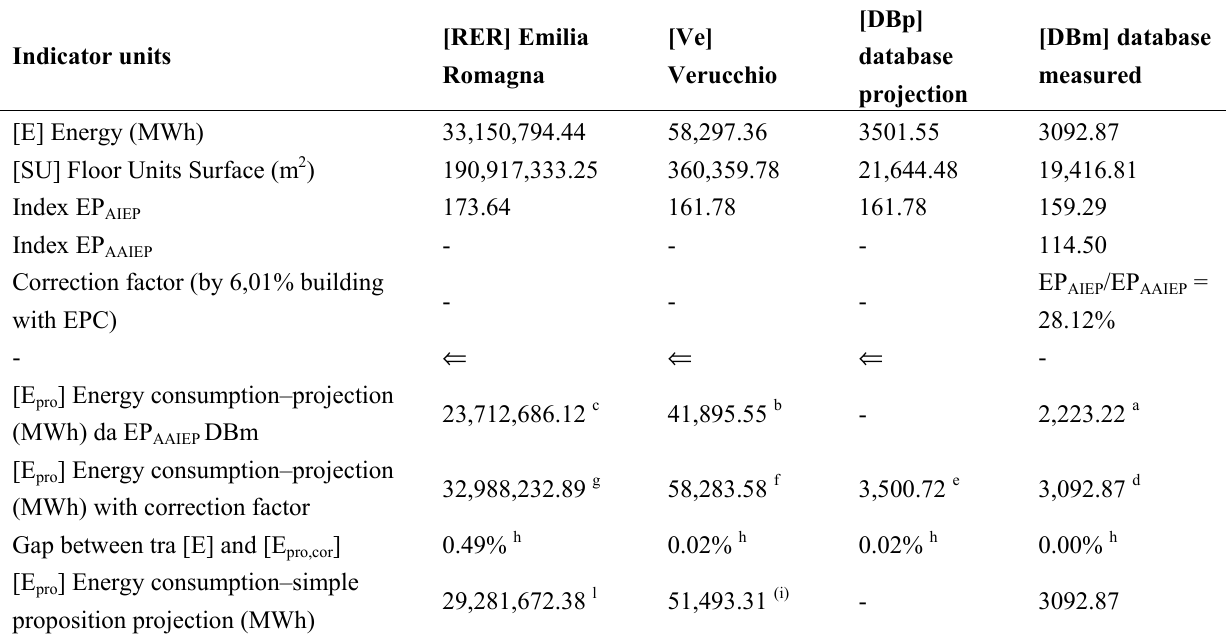
Table 7. Bottom-up to top-down